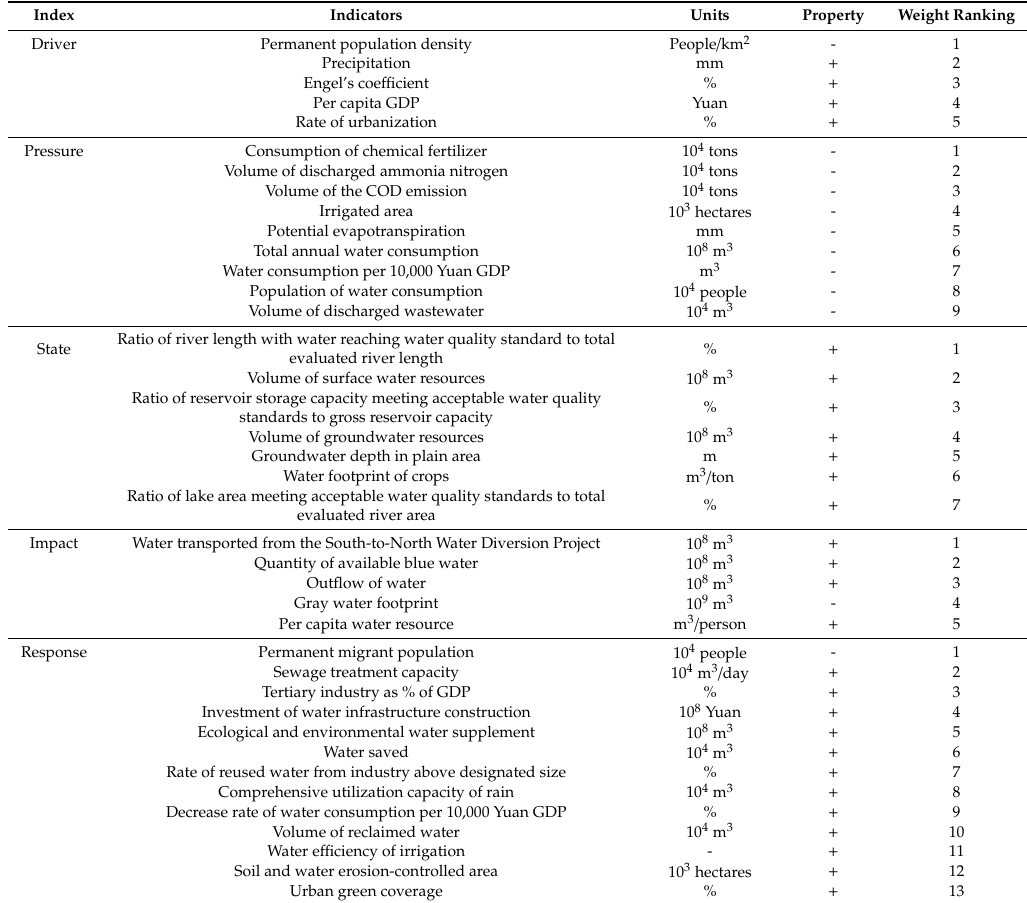
Table 1. Components of the indicators for each driver-pressure-state-impact-response (DPSIR) index and the interpretations. COD: chemical oxygen